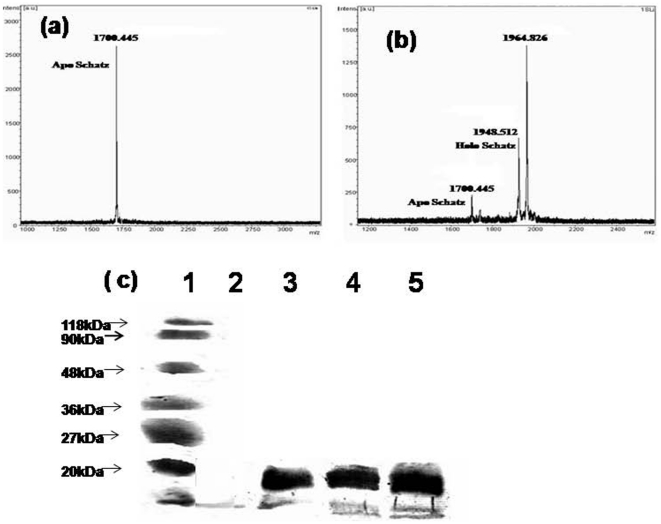
Biotinylation by MtBPL or
EcBirA.(a) Mass spectrum of Schatz peptide incubated with 500 µM biotin, 3
mM ATP and 100 nM MtBPL or EcBirA in
standard buffer. (b) Mass spectrum of Schatz peptide incubated with 500
µM biotin, 3 mM ATP and 100 nM EcBirA in standard
buffer. (c) Avidin blot of biotinylation of BCCP catalyzed by BPL. The
reaction was carried in standard buffer (10 mM Tris-HCl pH-8.0, 50 mM
KCl, 2.5 mM MgCl2) containing 3 mM ATP, 500 µM biotin,
2.5 mM MgCl2, 0.1 mM dithiothreitol, and 100 nM BPL and 5
µM BCCP87 for 30 min at 37°C. The reaction mixture
was then resolved on a 10% SDS PAGE and transferred to
nitrocellulose membrane. The membrane was then incubated with
streptavidin HRP for 1 h at room temperature and developed with
AEC/H2O2 (1) marker; (2)
EcBCCP87+MtBPL; (3)
MtBCCP87+MtBPL; (4)
EcBCCP87+EcBirA;
(5)
MtBCCP87+EcBirA.